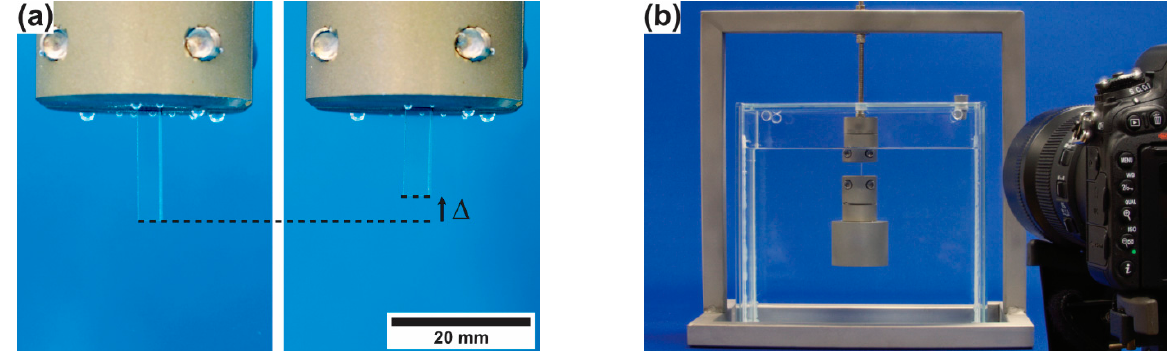
Figure 6. Experimental procedure to measure chemically triggered recovery. ( a ) Measurement of unconstrained recovery using rectangular specimens. Bubbles below grip indicate that specimen was induced in water. Left image: SMP-E specimen programmed to 50% exposed to water. Right image: Same specimen after 345,600 s (i.e., 96 h) of exposure. Black arrow indicates direction of positive deformation. ( b ) Documenting constrained recovery. SMP-E specimen programmed to 50% with end load (corresponding to 1.0 MPa) exposed to water at the beginning of the experiment. For quantitative evaluation, several hundred images were taken for each experiment in appropriate time intervals.